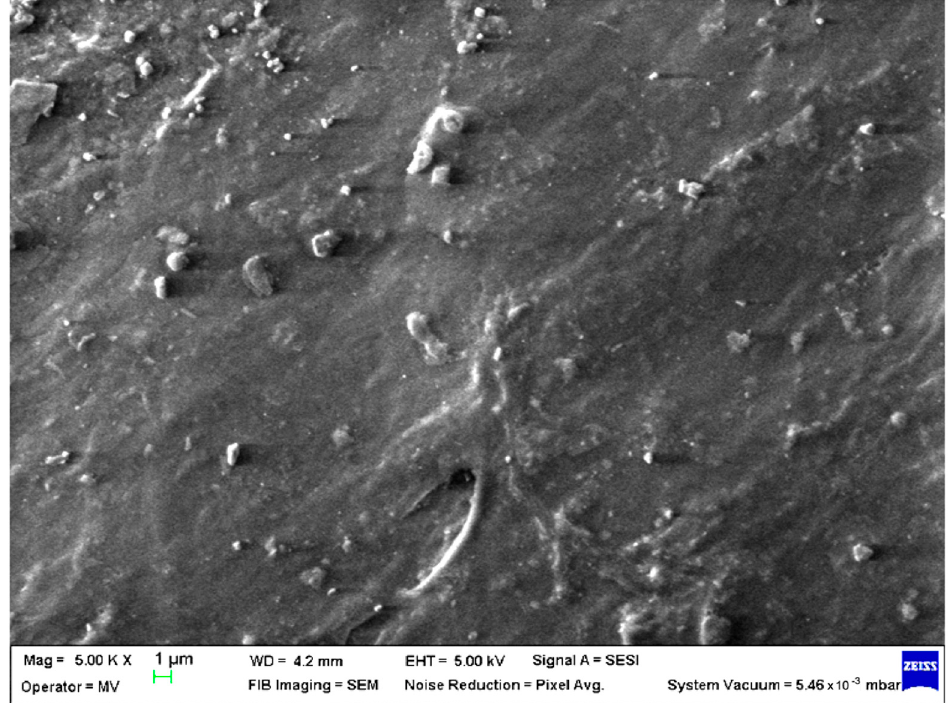
Figure 8. SEM micrographs of PET–PP–Al composite (M8) sample at T 0 (1 μ m scale).